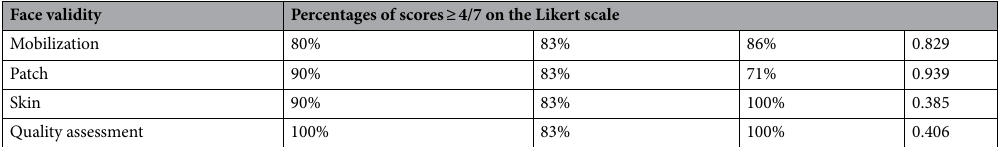
Table 2. Face and content validity of the model. There were no significant differences between each of the 3 specialties of fetal